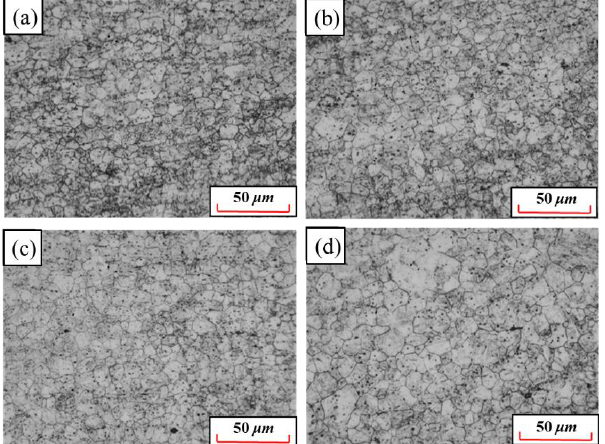
Figure 8. Grain distributions at different austenitizing temperatures: ( a ) 870 °C; ( b ) 900 °C; ( c ) 930 °C ( d ) 960 °C.